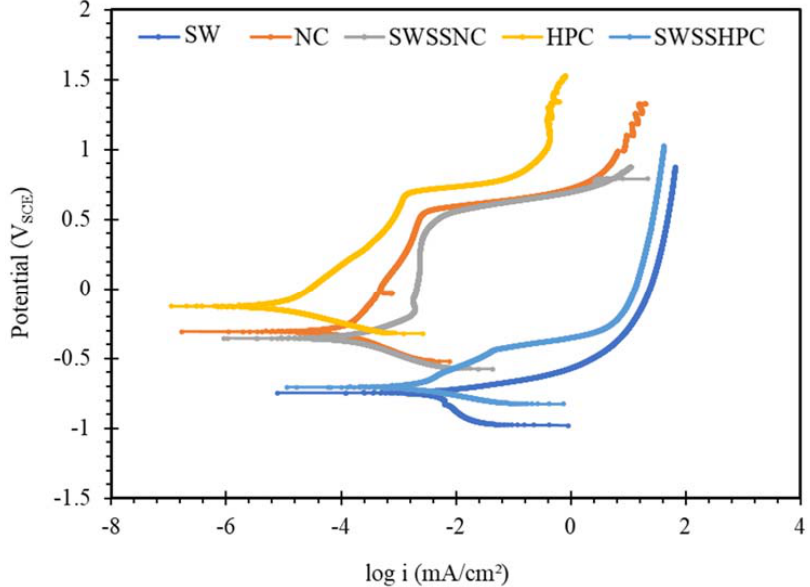
Figure 6. Polarization curves obtained for mild steel exposed to SW, NC, SWSSNC, HPC and SWSSHPC solutions for 168 h.